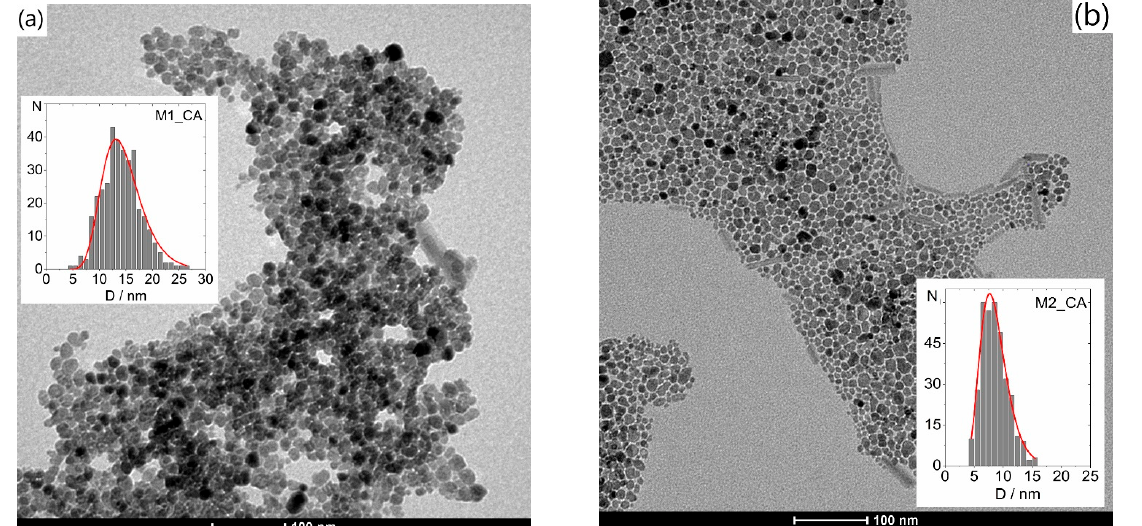
Figure 8. Typical TEM images of the grid-dried citric acid-based ferrofluids and corresponding size distributions for samples ( a ) M1_CA and ( b ) M2_CA.